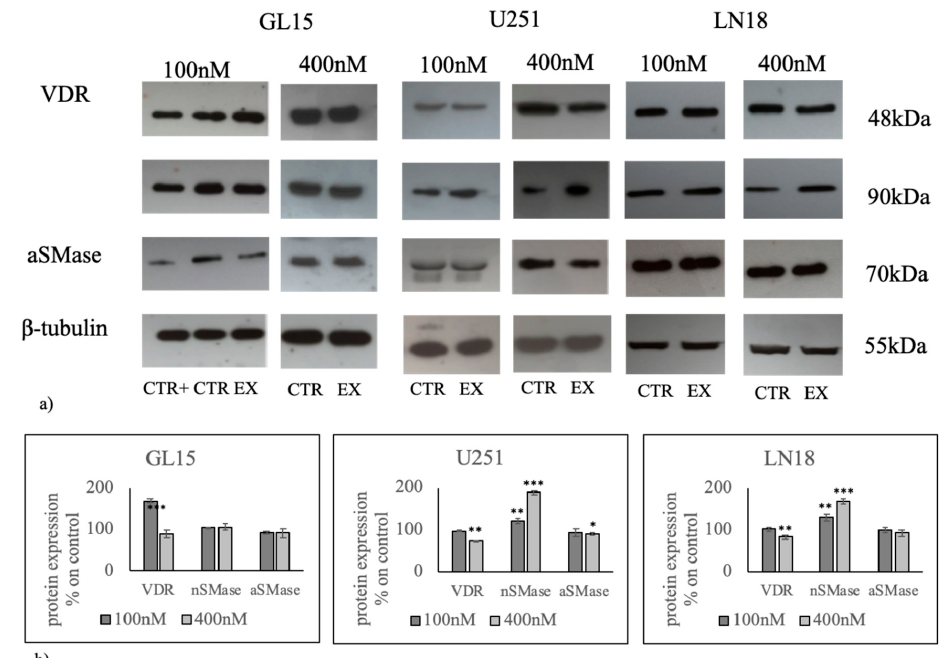
Figure 3. Effect of 100 nM and 400 nM 1 α ,25(OH) 2 D 3 on vitamin D receptor (VDR), neutral sphingomyelinase (nSMase), and acid sphingomyelinase (aSMase) protein regulation in GL15